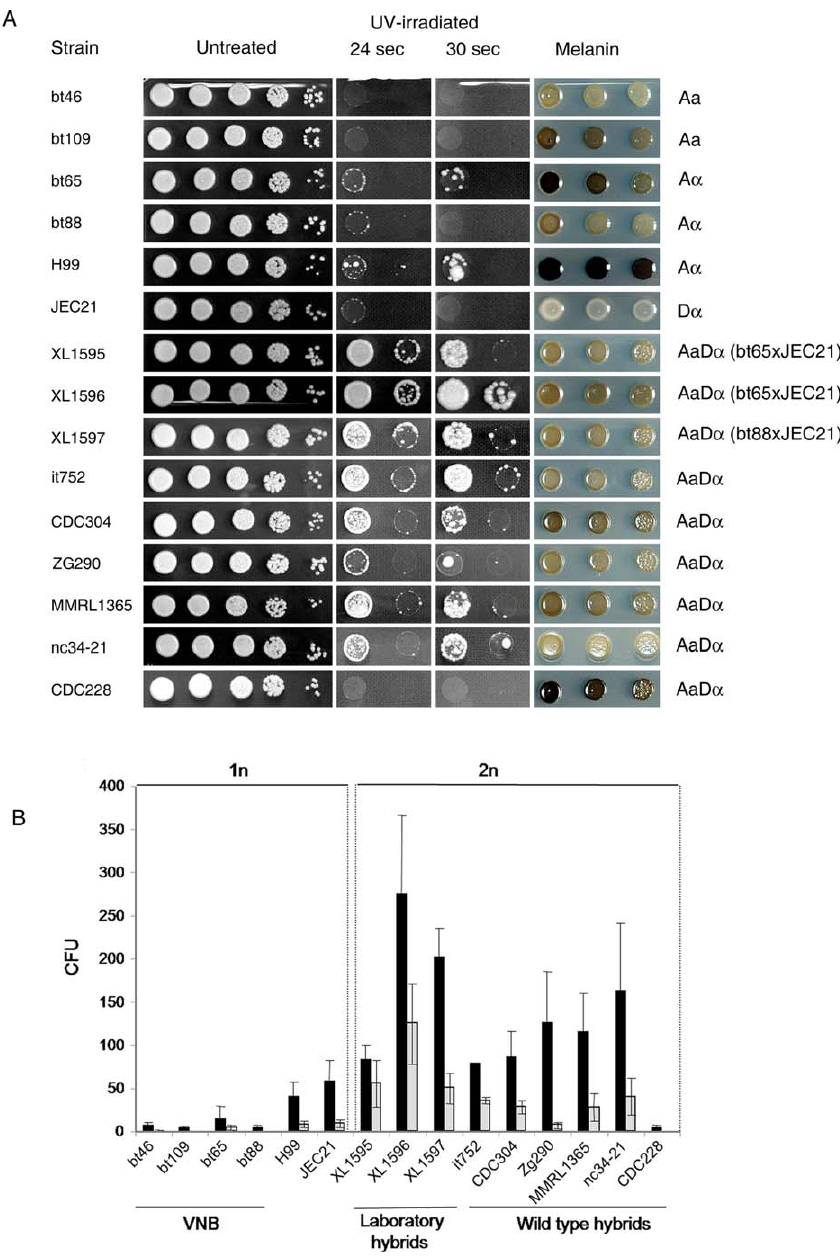
Figure 4. Natural and Laboratory A a D a Hybrids Are More Resistant to UV Irradiation Compared to Serotype A and Serotype D Haploid Strains (A) VNB strains are more sensitive to UV irradiation than isolates of serotype D, VNI strain of serotype A, and AD hybrid strains. Cells were grown overnight in liquid culture under the melanin-inducing conditions, and 10-fold serial dilutions of log-phase yeast cells of VNB strains, AD hybrid strains, and control serotype A and serotype D strains were plated in triplicates on YPD medium; plates were UV irradiated ( ; 48 mJ/cm 2 ) for 24 (second panel) or 30 seconds (third panel). To evaluate the amount of melanin produced, strains were spotted on the plates containing low-glucose L-DOPA medium (last panel). (B) Quantitative assessment of UV resistance for each strain. The highest dilutions that yielded colonies after treatment with UV were identified, and the number of individual colonies was determined within each spot corresponding to the highest dilution that yielded viable colonies. From this number, the total number of CFU that survived the treatment was determined and plotted. The experiment was performed in triplicate, and error bars represent standard error of the mean based on three replicates. Black bars represent cells irradiated for 24 seconds and grey bars represent cells irradiated for 30 seconds. Some AD hybrids are aneuploid ( . 1n but , 2n). doi:10.1371/journal.ppat.0030114.g004 larger sample of serotype A strains [22]. A a D a and A a D a ([40] and X. Lin, A. Litvintseva, K. Nielsen, S. Patel, A. Floyd, et al., unpublished data). strains are products of hybridization between isolates of opposite mating types (MAT a and MAT a ), whereas A a D a is an Genetic diversity among the isolates was also estimated by apparent product of mating between isolates of the same using AFLP, and the phylogenetic analyses based on these mating type, which was recently described in C. neoformans data demonstrated that the A a D a strains are more closely PLoS Pathogens |